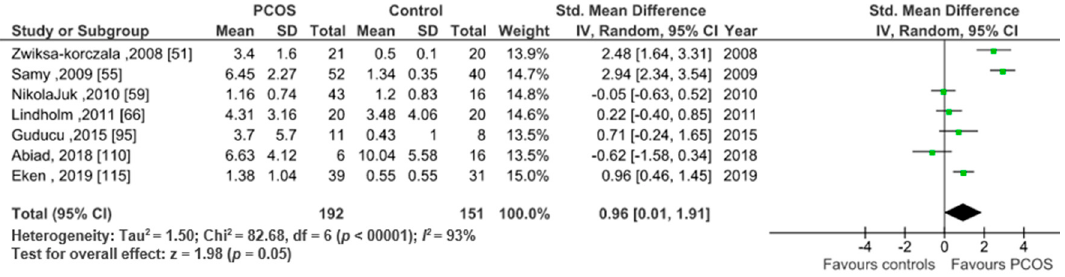
Figure 4. CRP subgroup analysis of 7 studies including obese women.